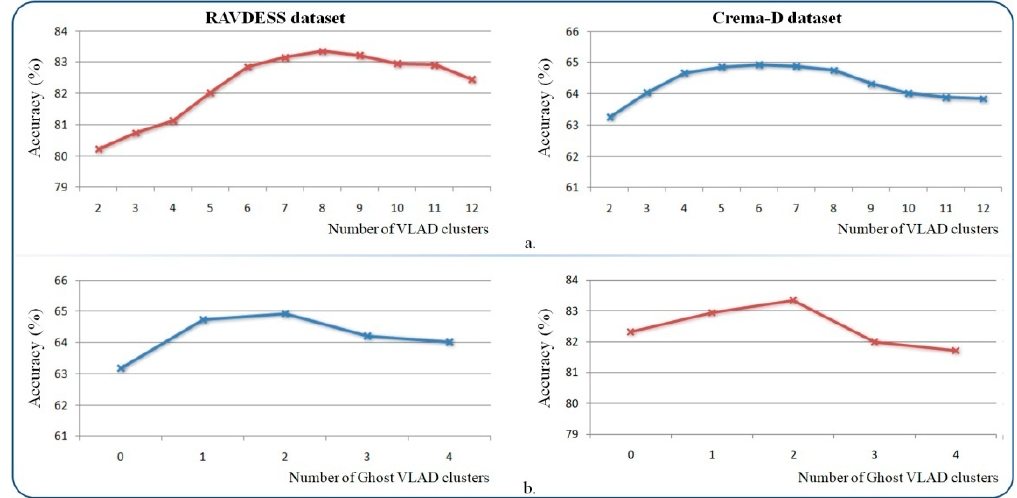
Figure 10. The system performance evaluation on RAVDESS and CREMA-D datasets with the different parameters involved: ( a ) the number of NetVLAD clusters ( K ) and ( b ) the number of GhostVLAD clusters ( G ).